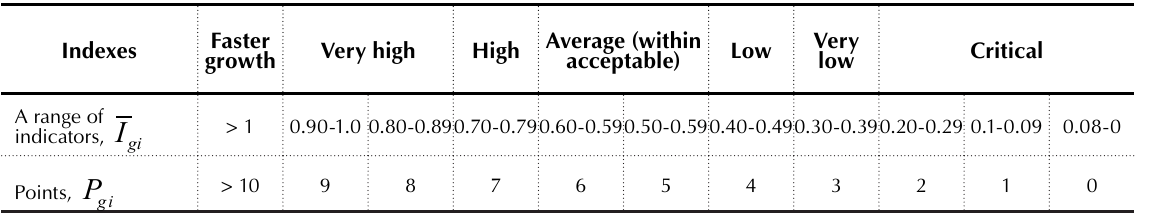
Table 1. Еvaluation of standardized indicators